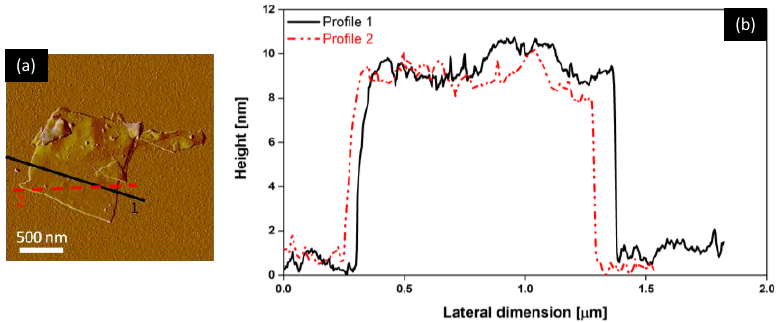
Figure 7. AFM image of the GNPs ( a ) and their corresponding height profiles ( b ).